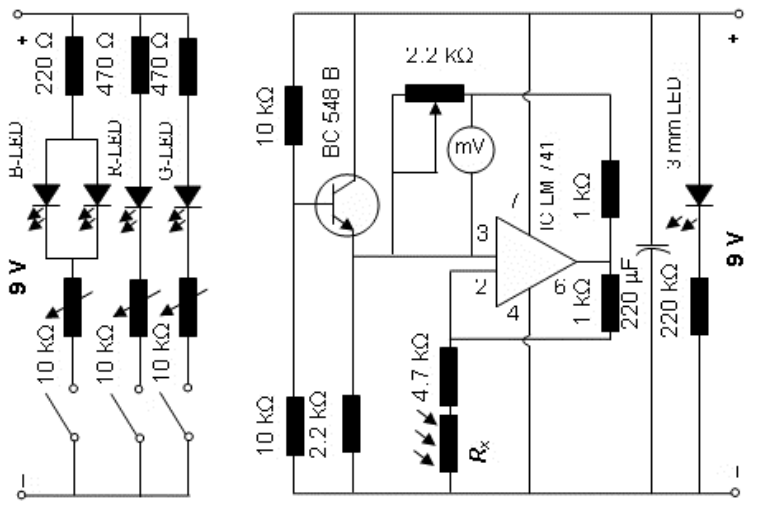
Figure 13. Electronic circuitry for powering the tri-colour LED (left) and the photometric detection system